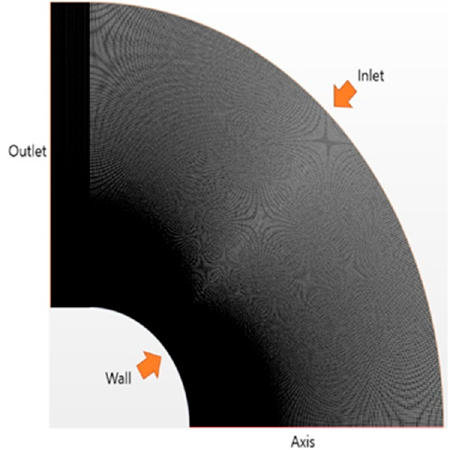
Figure 1. Computational grid for energy deposition in front of the sphere.